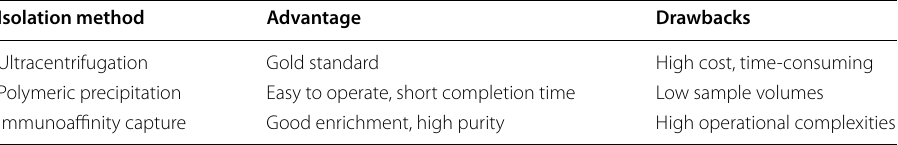
Table 2 Comparison of different isolation